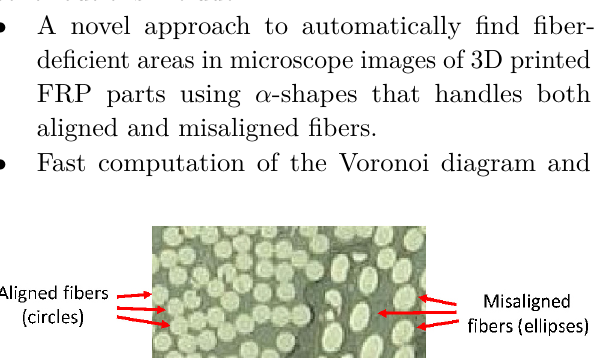
Fig. 2 Aligned fibers, with circular cross-sections, and misaligned fibers, with elliptical cross-sections.